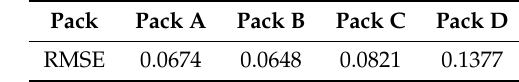
Table 3. The RMSE values of the reliability estimated by the test data and the reliability estimated by the RBD model.